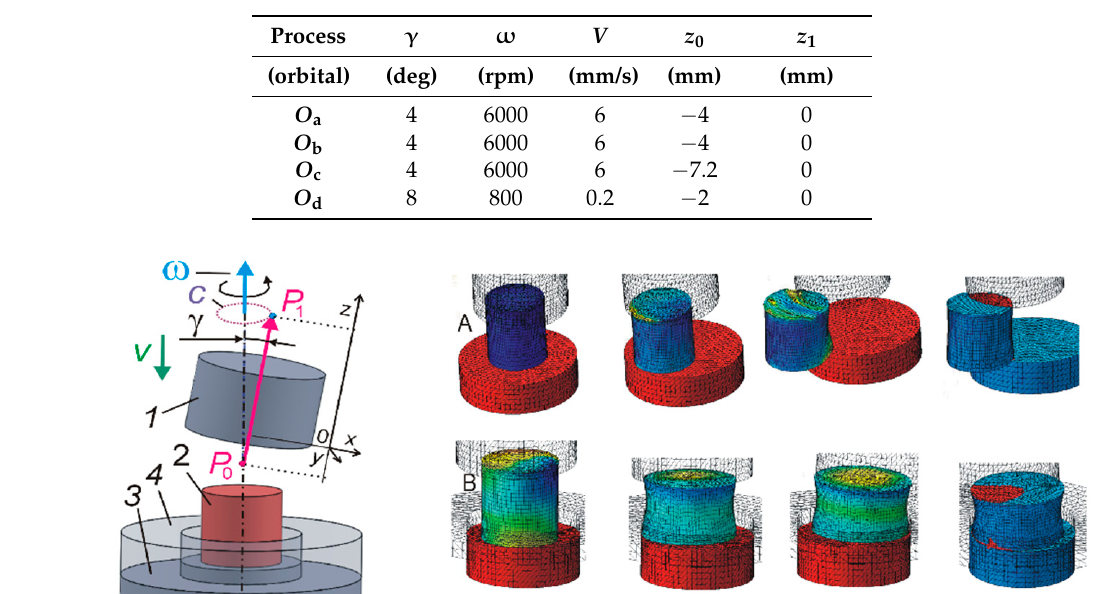
Table 3. Punch kinematic parameters.